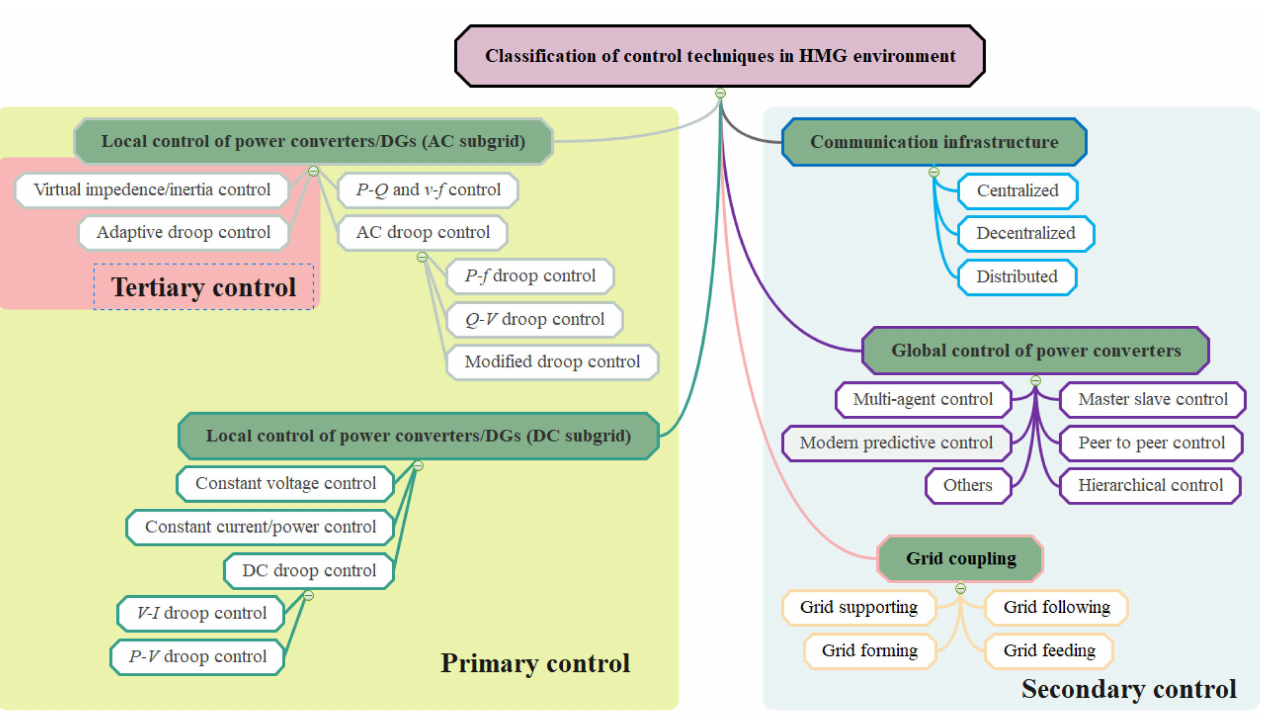
Figure 9. Global control strategies for